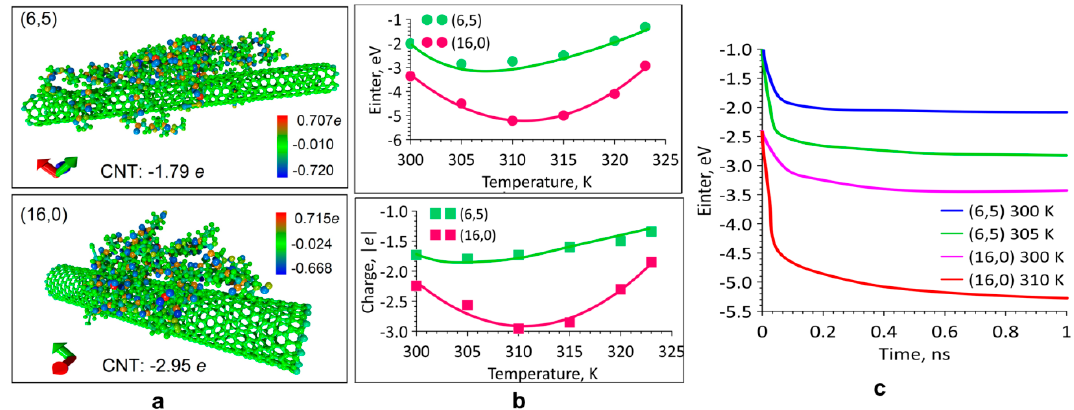
Figure 2. The binding energy of the SWCNT / collagen II complex and charge transfer: ( a ) Distribution of electron charge density; ( b ) Graphs of bonding energy and charge at SWCNT; ( c ) Graphs of the change in binding energy over time.